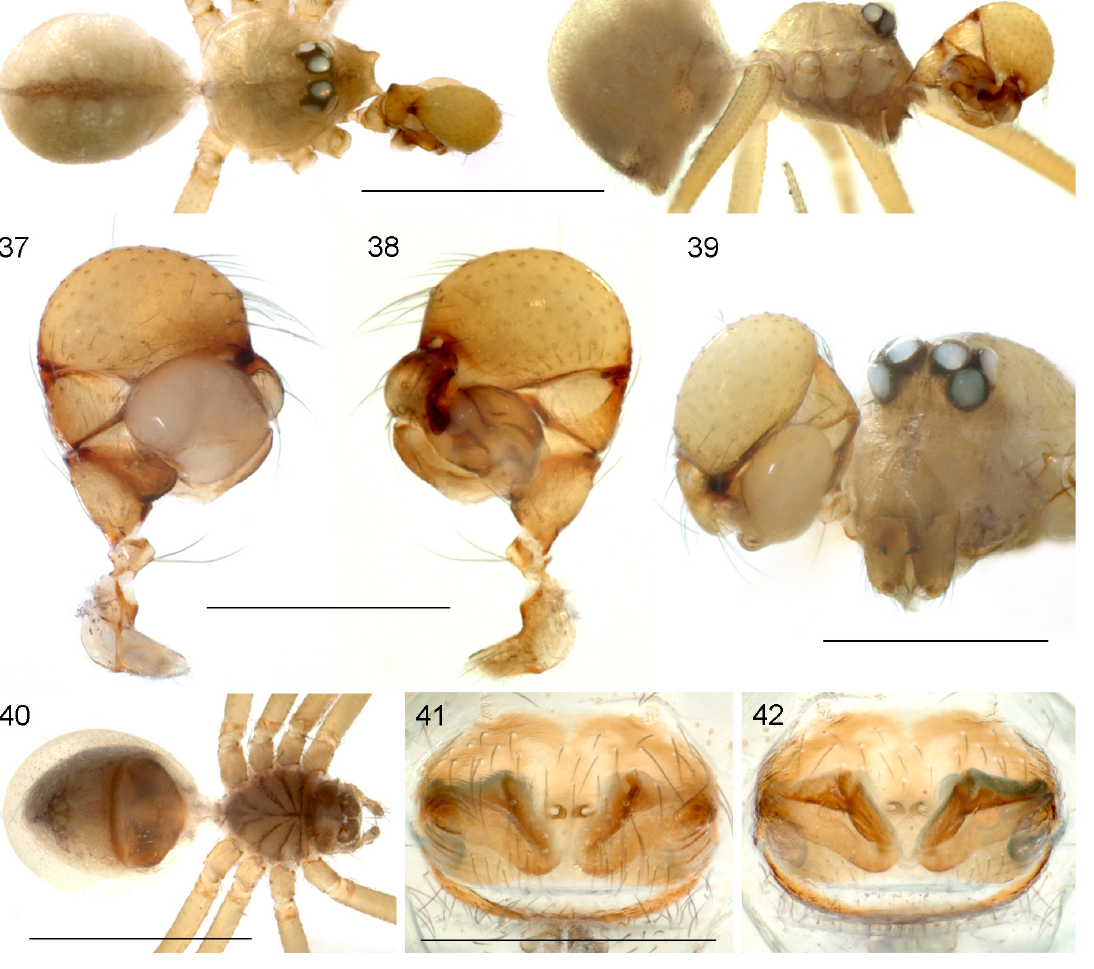
Figs 35-42. Anansus atewa sp. nov. 35-36 . ♂, dorsal and lateral views. 37-38 . Left ♂ palp, prolateral and retrolateral views. 39 . ♂ prosoma and right palp, oblique frontal view. 40 . ♀, ventral view. 41- 42 . Cleared ♀ genitalia, ventral and dorsal views. Scale lines: 35-36, 40 = 1 mm; 37-39, 41-42 = 0.5